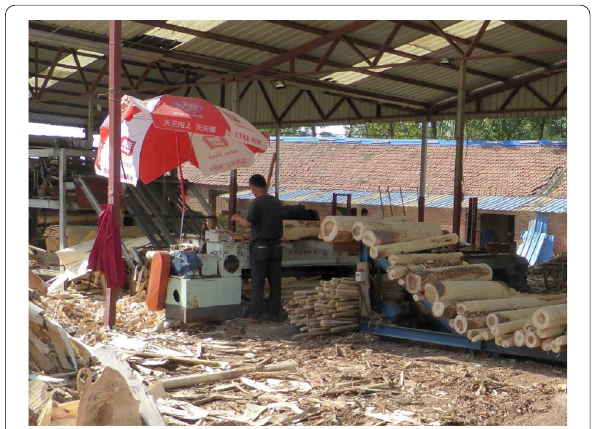
Fig. 1 Rotary lathe mill for the poplar veneer in Lianyungang, China